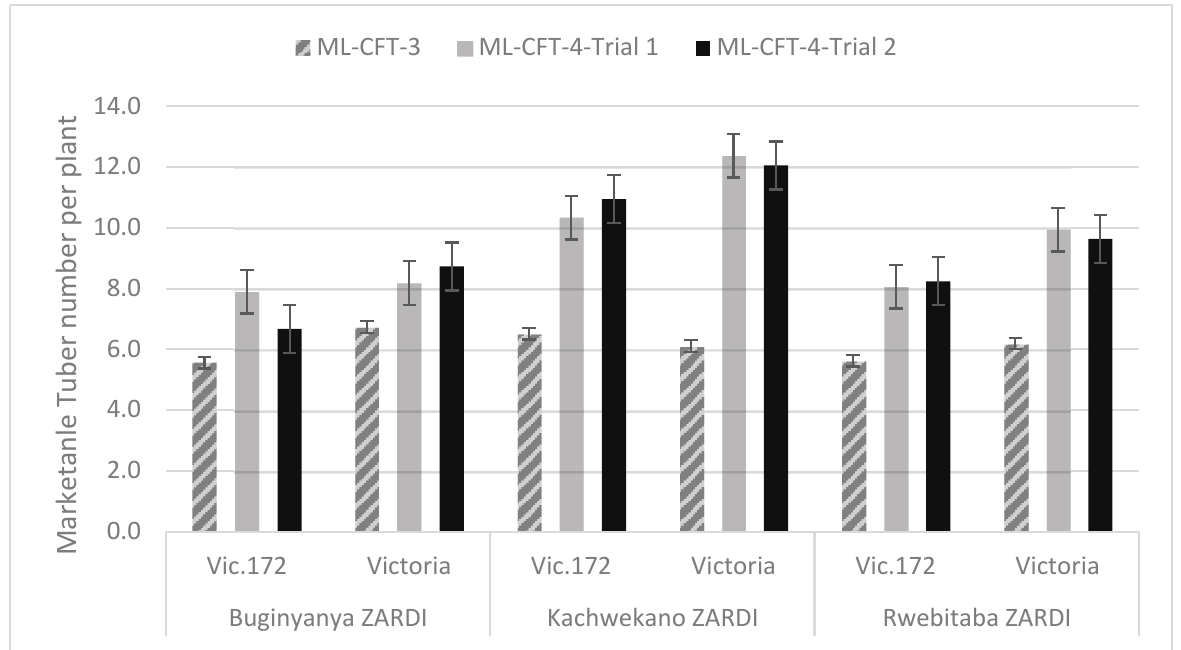
Figure 6. Average number of marketable tubers per plant for the transgenic event Vic.172 and the variety Victoria at the three locations. Error bar represents the standard error. The analysis of variance (ANOVA) on the average number of marketable tubers per plant between the transgenic event Vic.172 and the variety Victoria, and across locations, showed no statistically significant differences ( p > 0.05) for genotypes, location, and